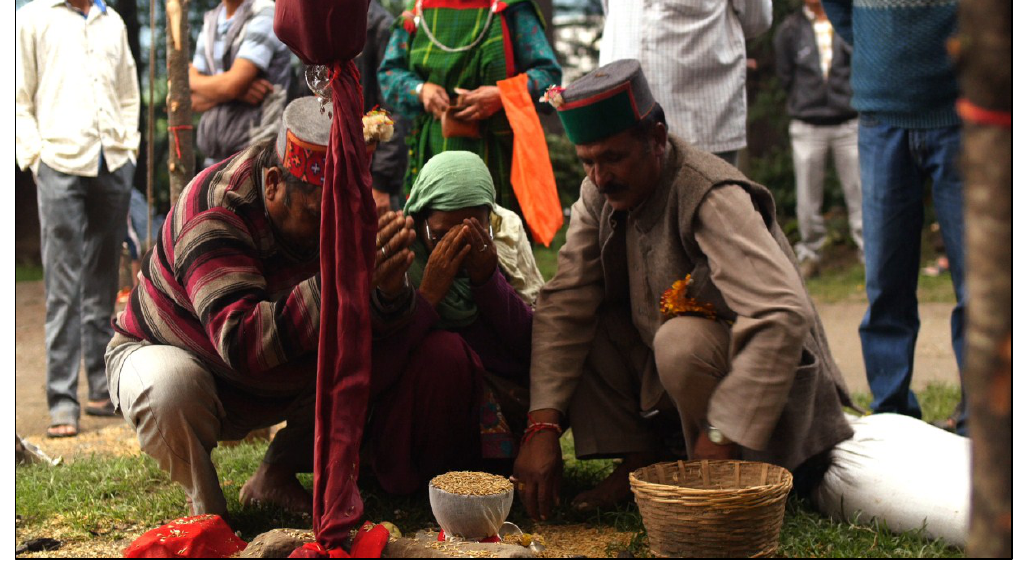
Figure 3. Private Chidra Yajna.